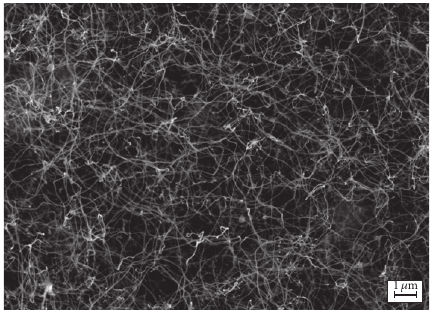
Figure 1: SEM image and schematic view of a fragment of conical carbon